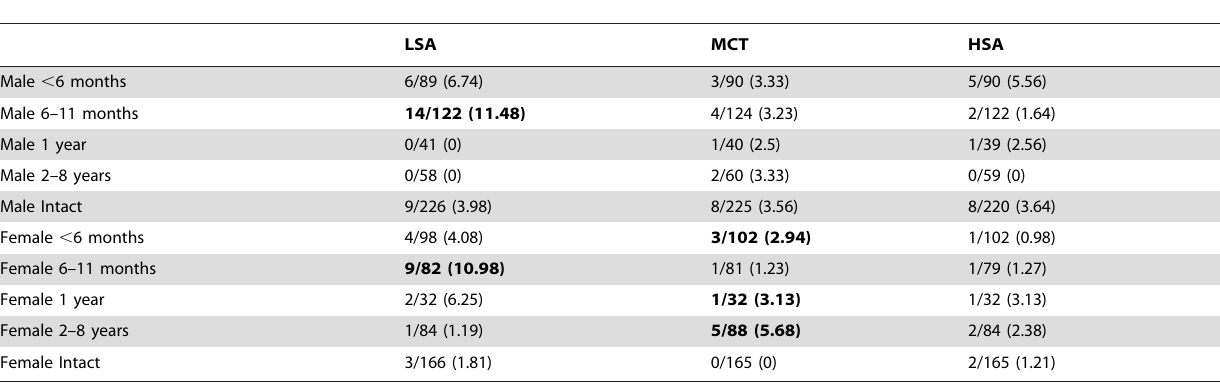
Table 3. Golden Retriever males and females,